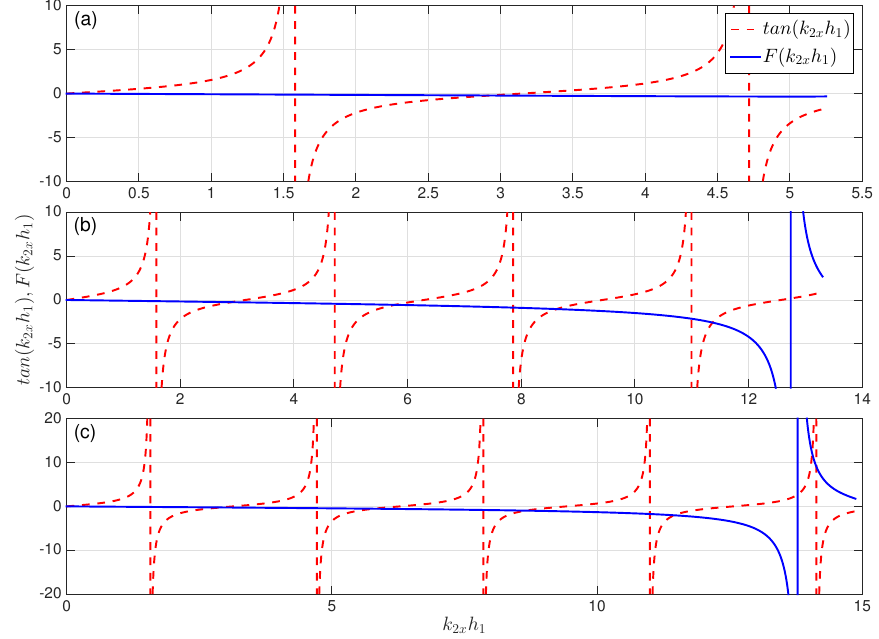
Figure 3. Graphical determination of k 2 x h 1 for guided modes in ( 0, h 1 ) . The red and blue curves correspond to tan ( k 2 x h 1 ) and F ( k 2 x h 1 ) , respectively. The energy of incident electron is ( a ) E = 56 meV; ( b ) E = 94 meV; and ( c ) E = 110 meV. The other parameters are the same as those in Figure